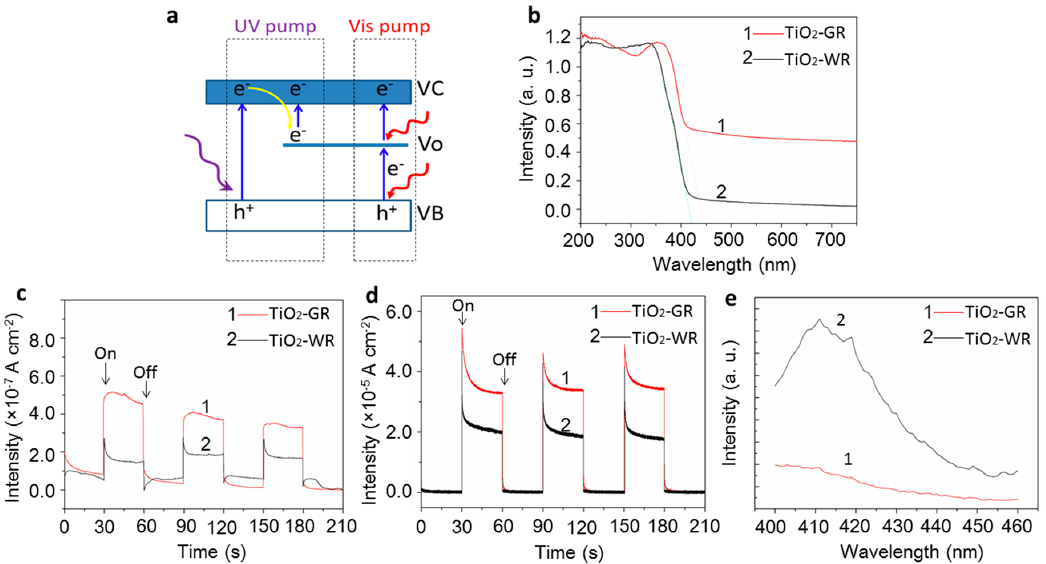
Figure 6. ( a ) Schematic illustration of the photocatalysis mechanism of TiO 2 -GR; ( b ) UV-vis diffuse reflectance spectra of TiO 2 -GR and TiO 2 -WR; ( c ) photocurrent density of TiO 2 -GR and TiO 2 -WR under visible light irradiation; ( d ) photocurrent density of TiO 2 -GR and TiO 2 -WR under full-spectrum light irradiation; ( e ) photoluminescence spectra of TiO 2 -GR and TiO 2 -WR with an excitation wavelength of 380 nm.